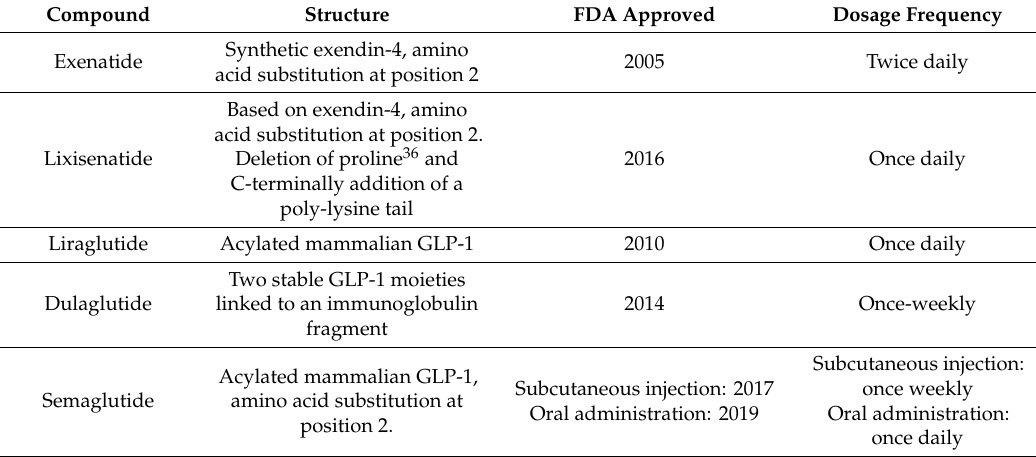
Table 1. Overview of structure, date of FDA approval and dosage frequency of diverse GLP-1 receptor agonists